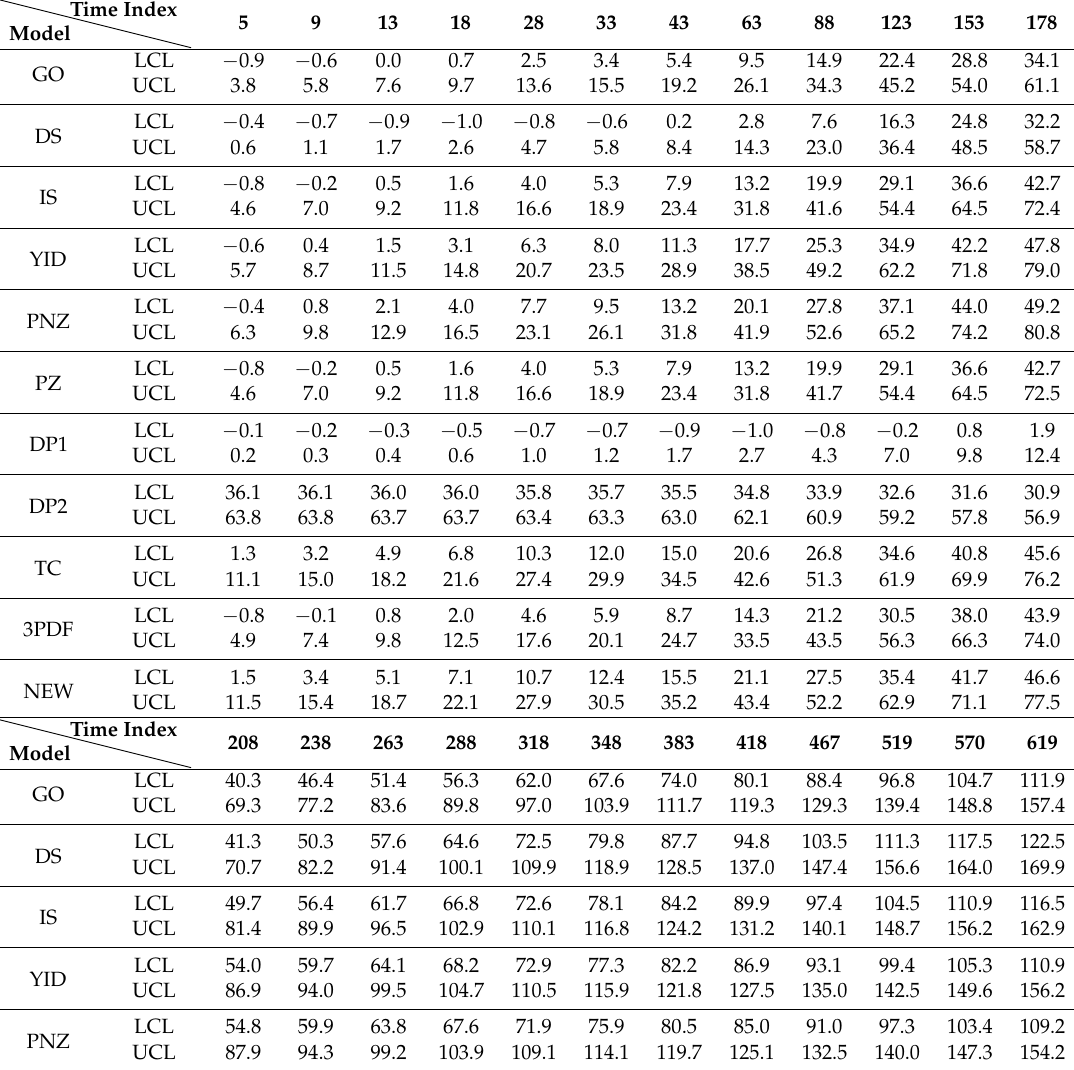
Table A2. Confidence interval of all 11 models from Dataset #2 ( α =